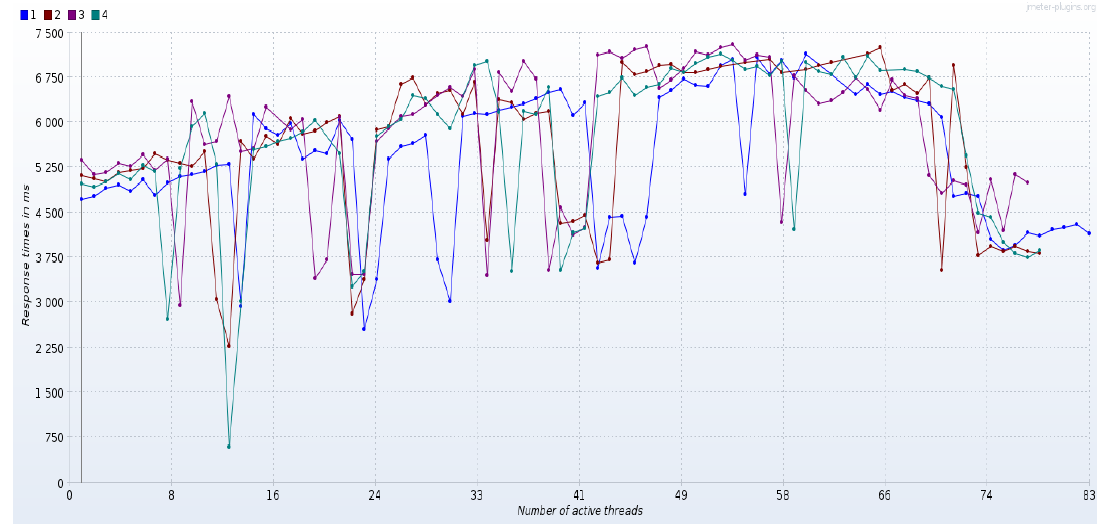
Figure 12. Overall results of the throughput in the local machine.